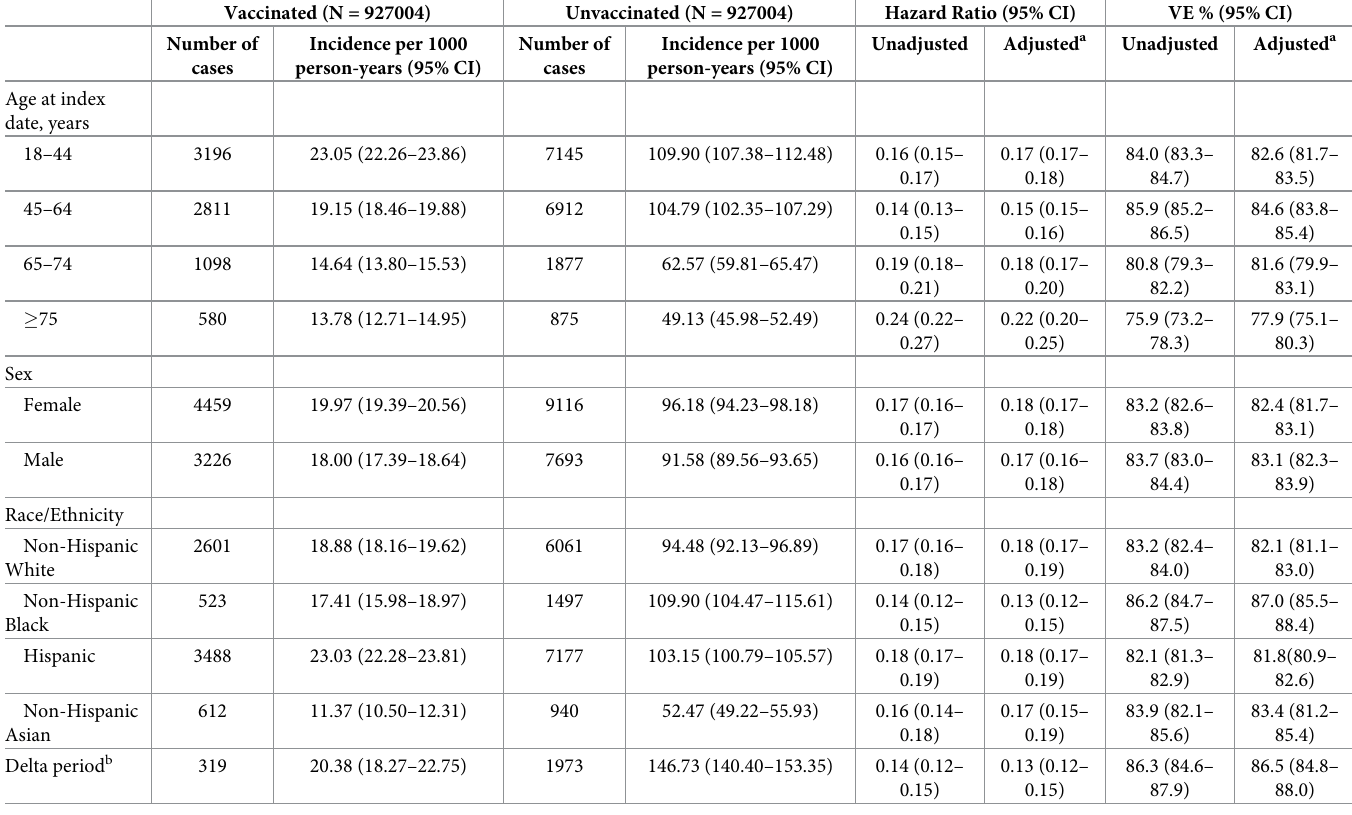
Table 3. Incidence rate, hazard ratio, and vaccine effectiveness of 2 doses of mRNA-1273 in preventing SARS-CoV-2 infection by age, sex, race/ethnicity, and Delta period subgroups. Vaccinated (N = 927004) Unvaccinated (N = 927004) Hazard Ratio (95% CI) VE % (95%